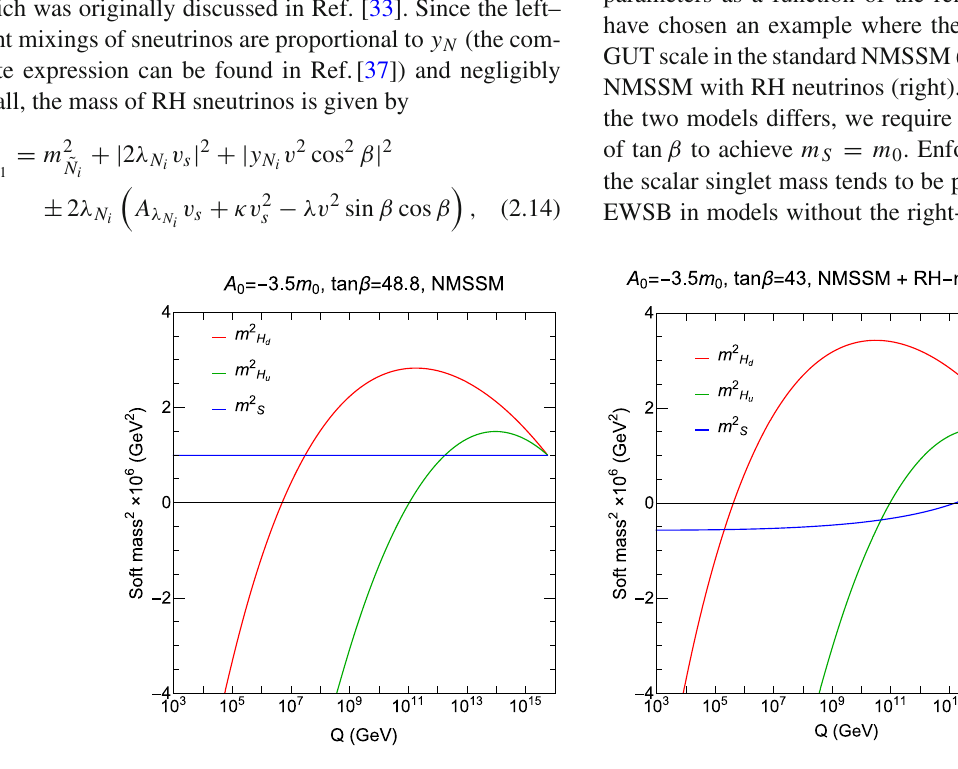
, corresponds to the standard NMSSM (i.e., with λ N = 0). The plot on H d the right corresponds to the extended NMSSM with RH neutrinos for λ = ( 0 . 0002 , 0 . 6 , 0 . 6 ) , defined at the GUT scale. The value of tan β N has been fixed separately in each example in order to achieve univer-